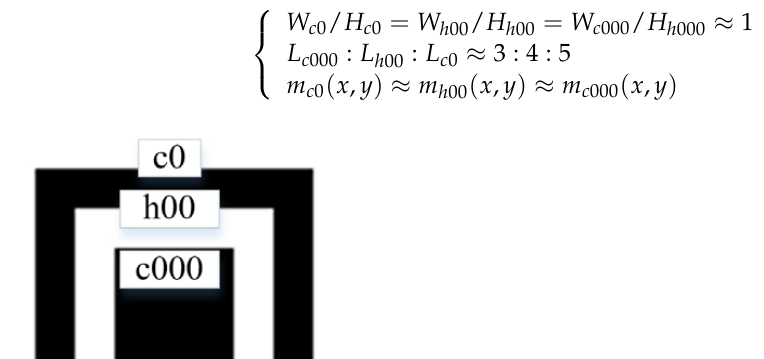
the contour. Because this feature has a high level of anti-interference, the topology, shape, and statistical moments of the contours can be used to locate the position detection patterns. The specific judgment conditions are as follows: